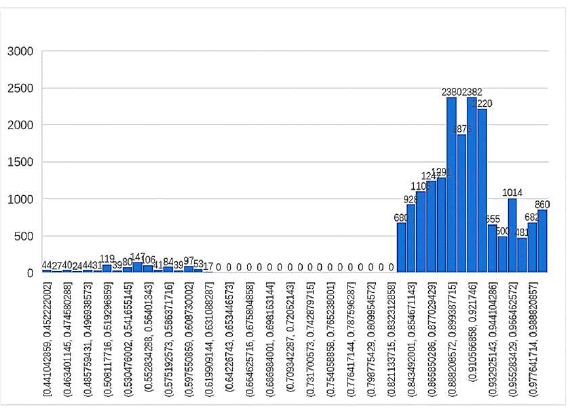
Figure 10. Distribution histogram of evaluation index valued of two-word geographical names.